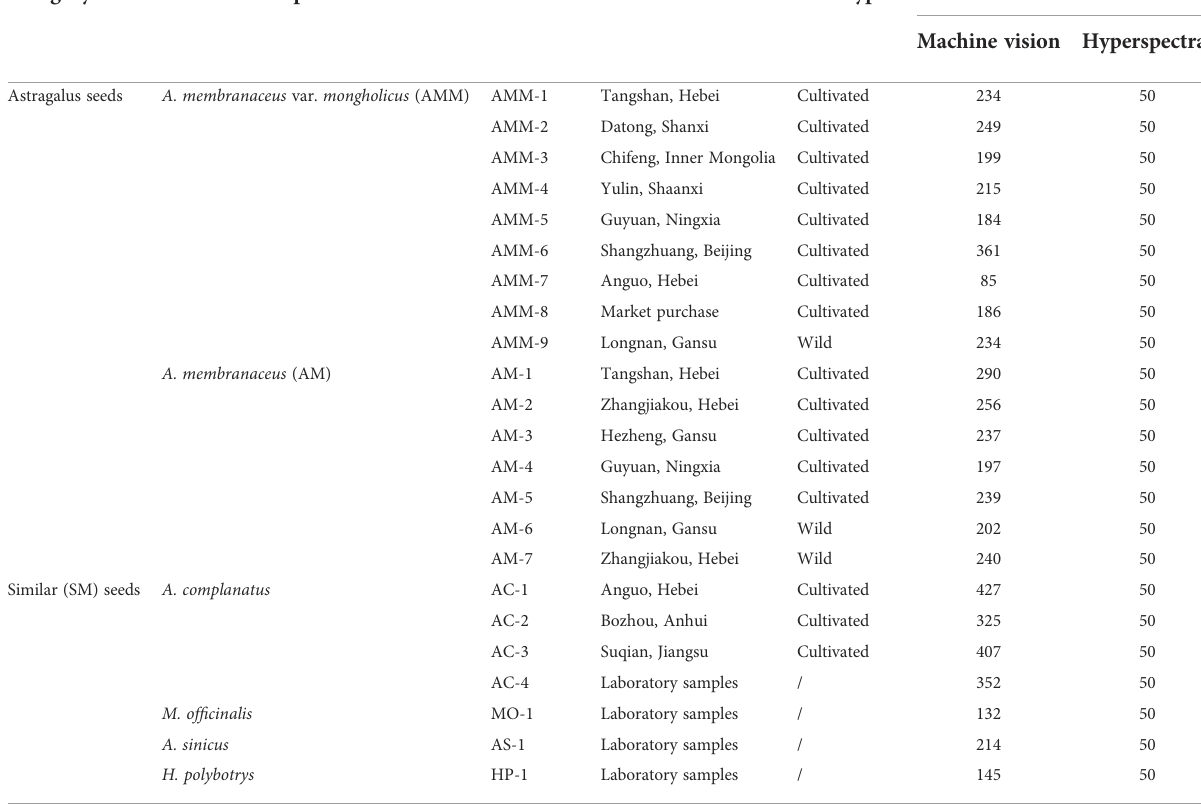
TABLE 2 Table of